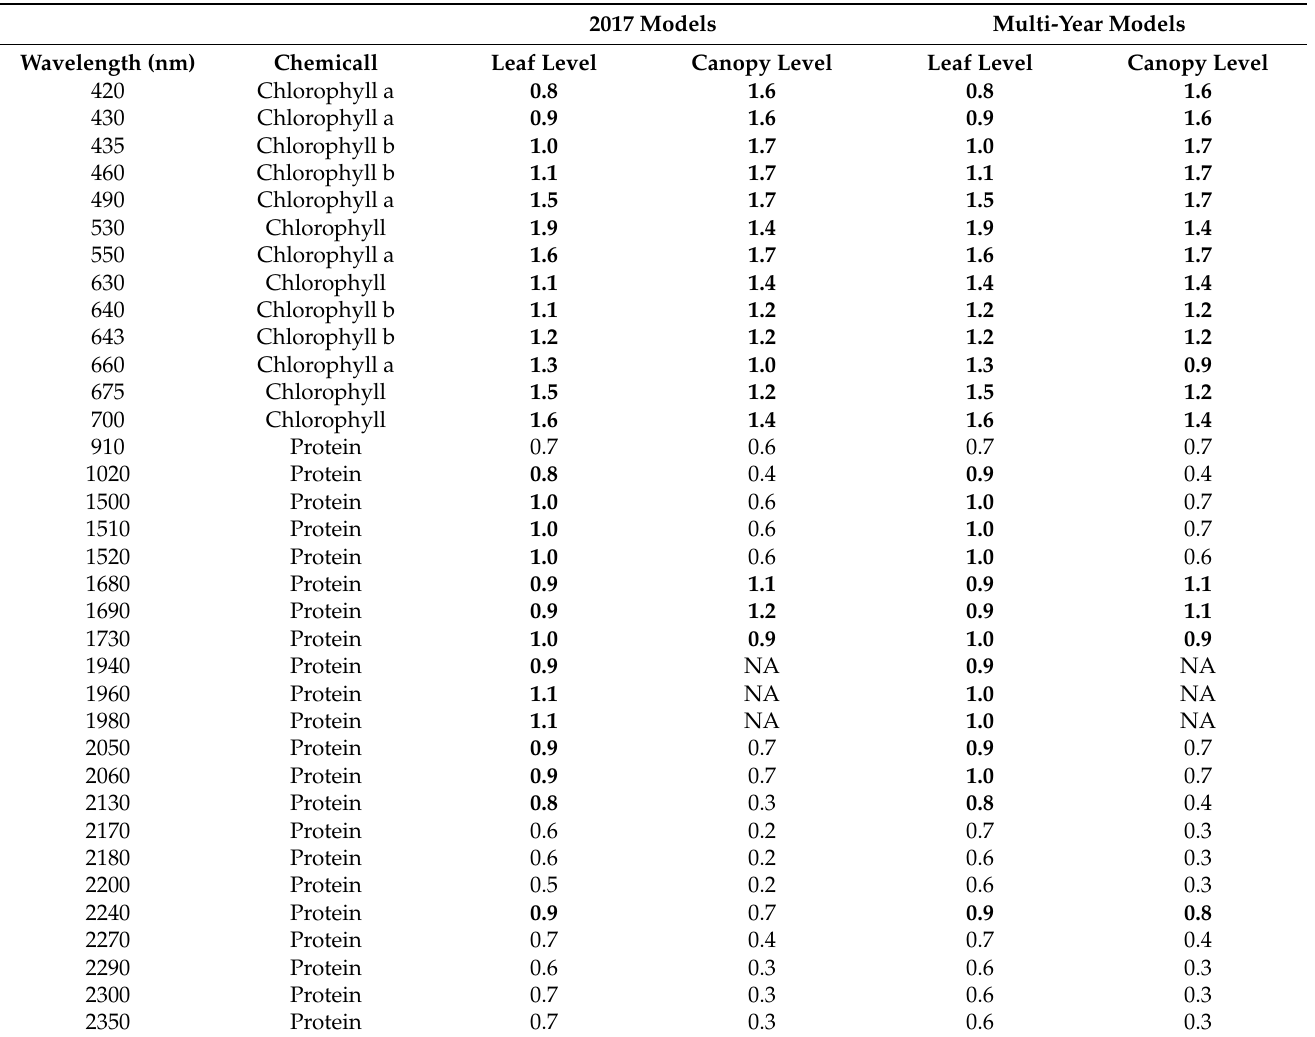
Table A5. Variable importance for the projection (VIP) values of wavelengths associated with chlorophyll a and b combined, chlorophyll a, or chlorophyll b, and protein absorption feature for 2017 and multi-year models at both leaf and canopy levels. Bold values, VIP ≥ 0.8. NA, wavelength removed from the canopy